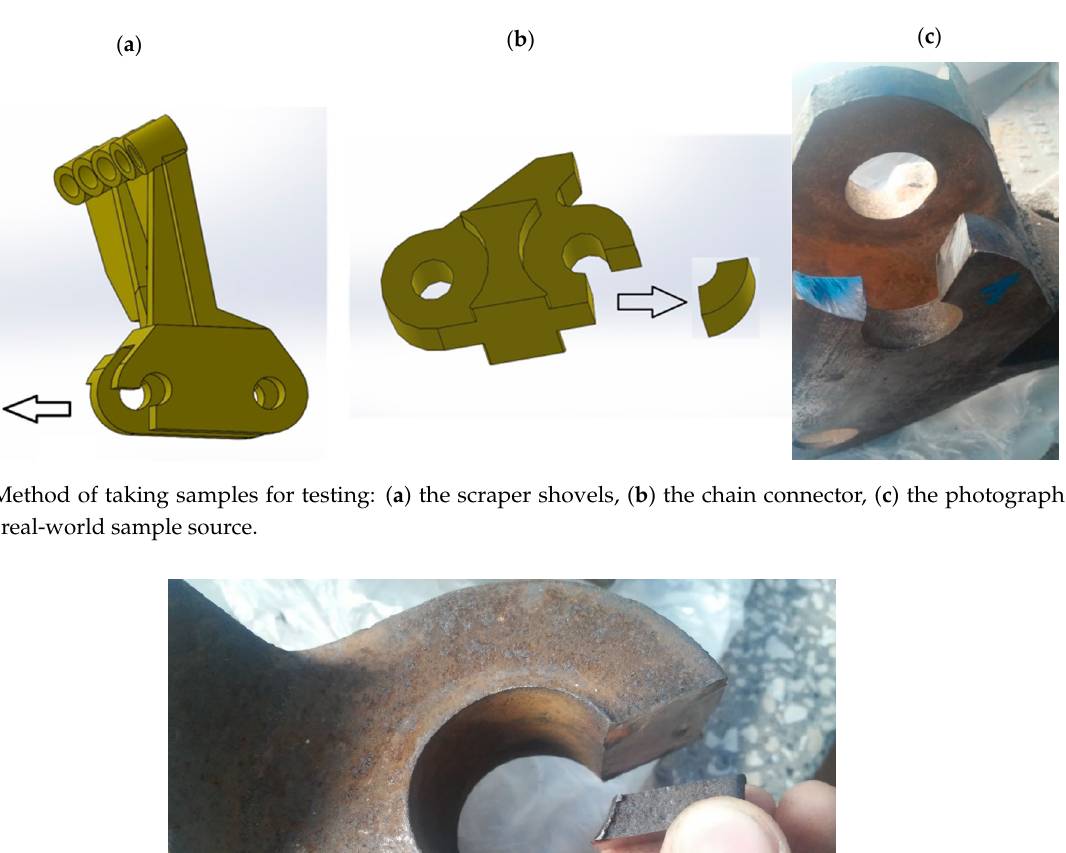
Figure 4. A view on the measured region of the wear-caused dimensional deviations of the in- spected parts.